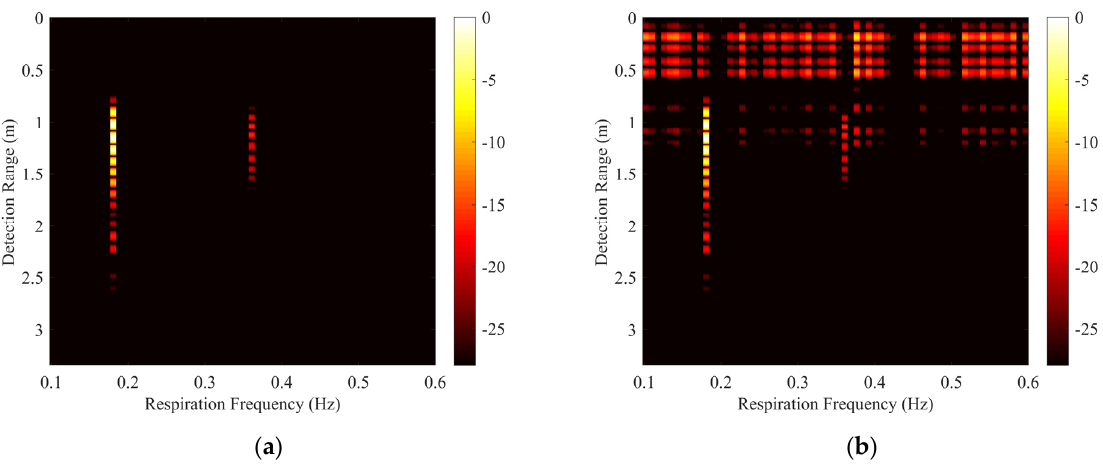
Figure 5. Simulated results. ( a ) The direct Fast Fourier transform (FFT) result of the raw echo signal without timing jitter, and ( b ) the direct FFT result of the raw echo signal with timing jitter.